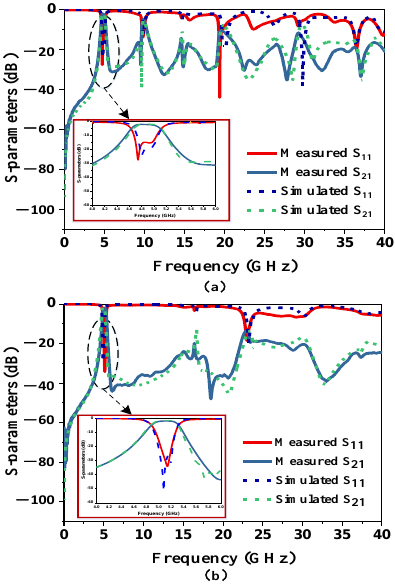
Figure 5. Comparison between simulation and measurement of both BPF. ( a ) CSL filter, ( b ) PWS filter.